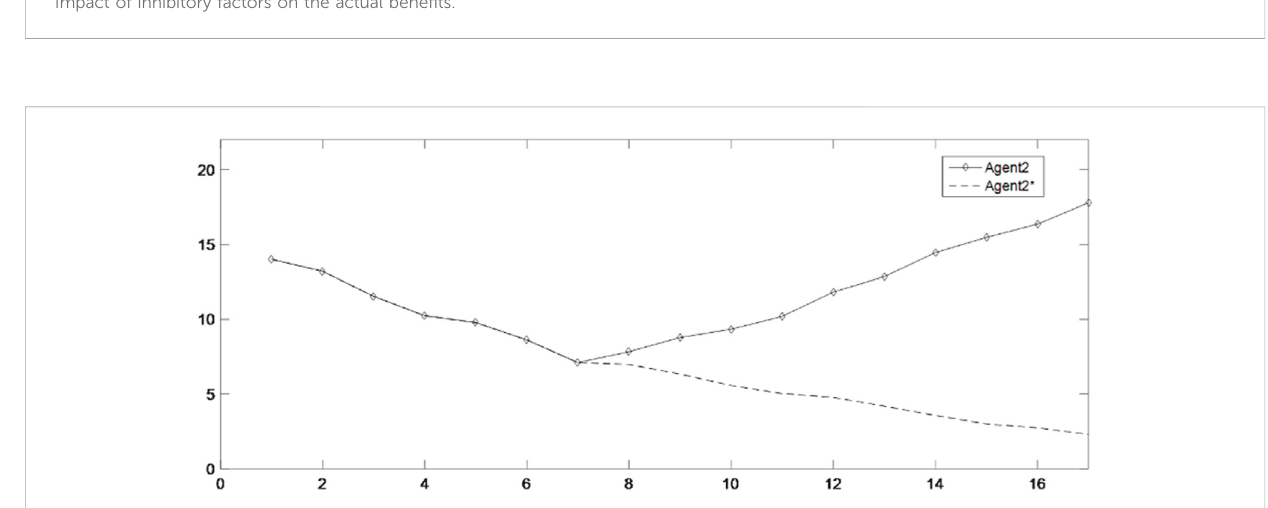
FIGURE 9 Impact of enhancement factors on the actual bene fi